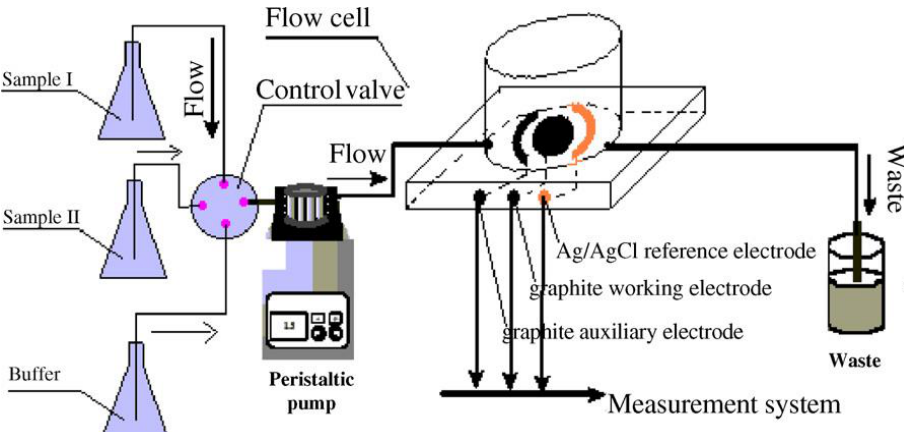
Figure 14. Schematic illustration of the flow-injection immunoassay system for IL-6 determination. HRP-labeled anti-IL-6 Ab immobilized on a SPCE coated with AuNPs generate redox signal with thionine and H 2 O 2 substrates. This coupled reaction is hindered with IL-6 binding. Reprinted from [101] with permission from Elsevier.